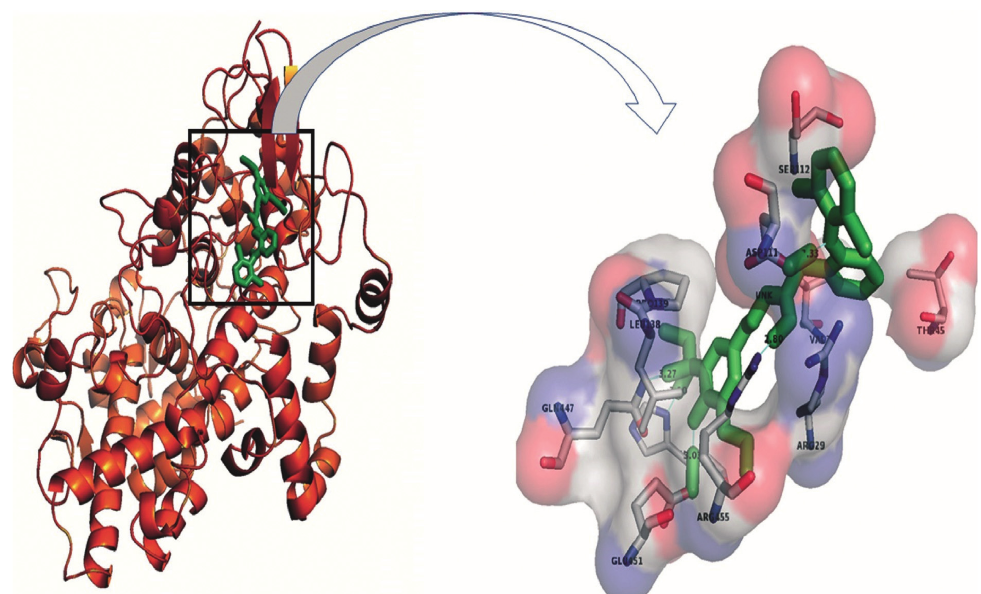
Figure 4: Binding of compound 8 with COX-2 protein. In zoom-in subset, the amino acid residues which are involved in the binding with the drug can be